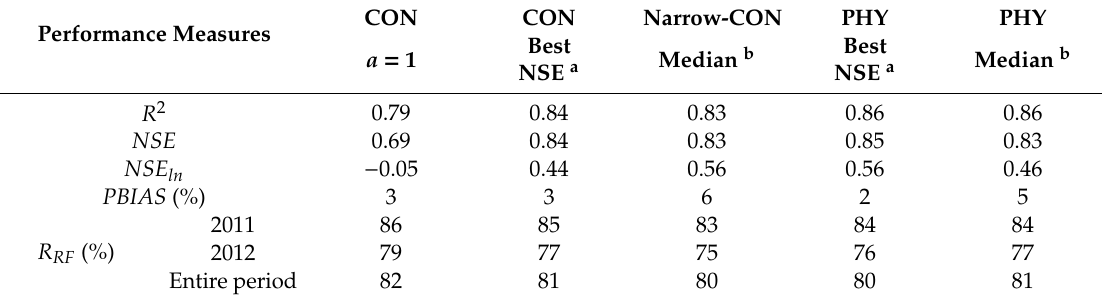
Table4. Performancemeasuresoftheuncalibrated, ensemble, andcalibratedCONandPHYapproaches. Performance